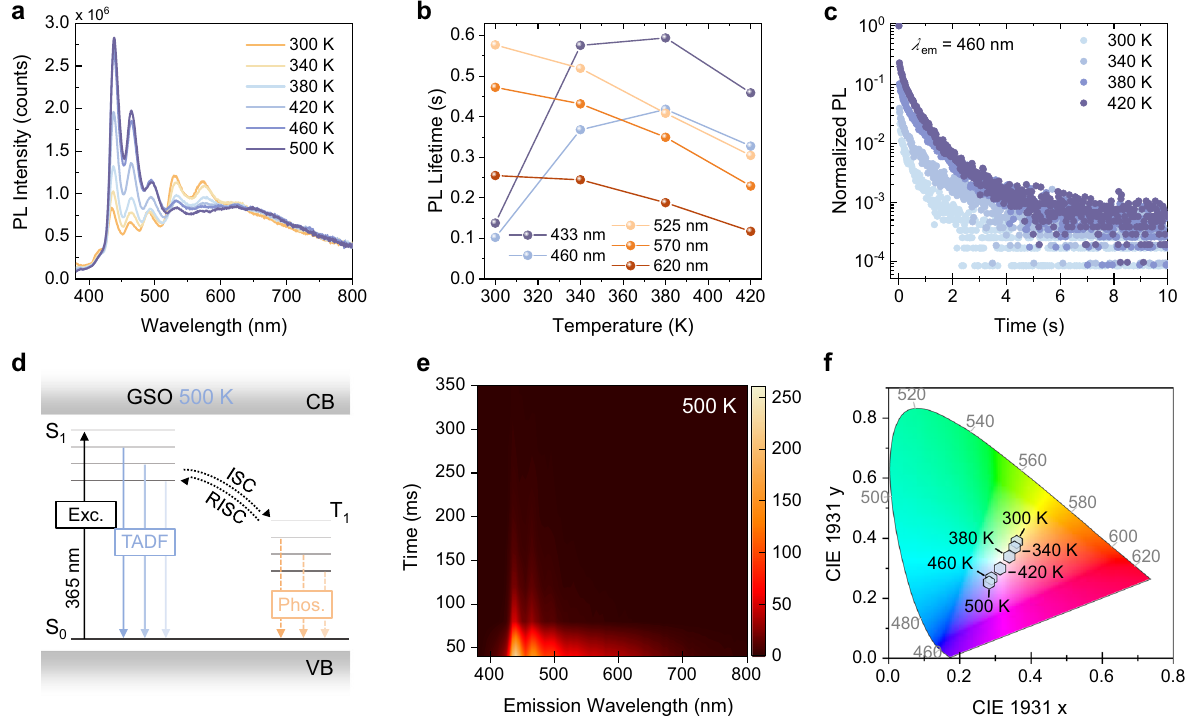
Fig. 4 | Photophysical properties of GSO at elevated temperatures. a Temperature-dependent PL spectra ( 휆 ex =300nm). b Temperature-dependent PL lifetimes atthe major emission peaks. c Normalized temperature-dependent PL decay curves from 300 to 420K ( λ em =460nm) d Proposed energy transfer pro- cessesofSampleIIIathightemperatures.Blue-bandTADFisgeneratedthroughthe